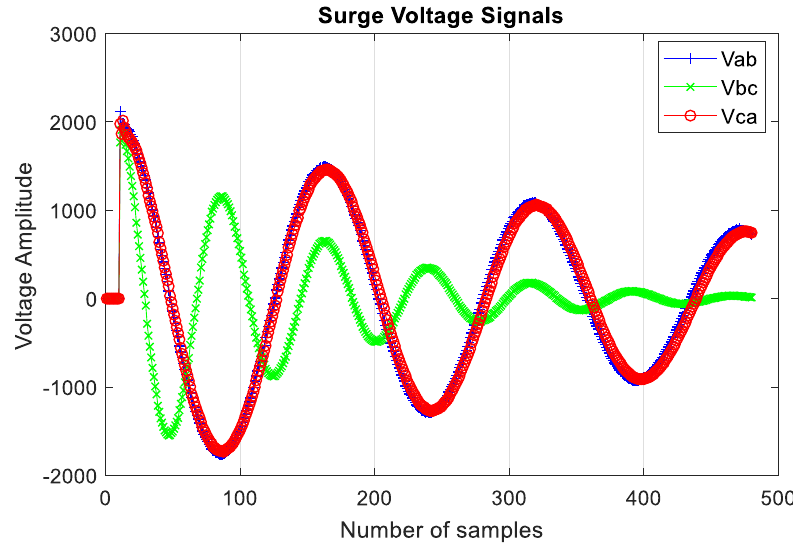
Figure 2. Surge comparison test signals (turn insulation failure example).